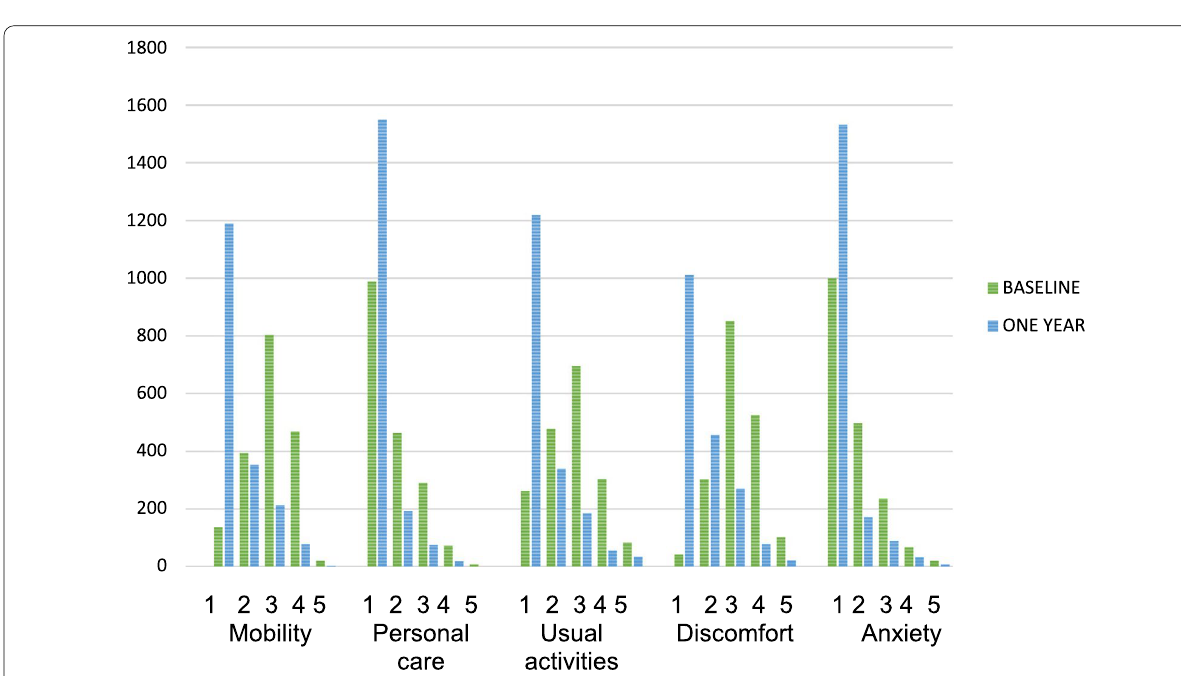
Fig. 2 Distribution of EQ5D domain scores at baseline and one year